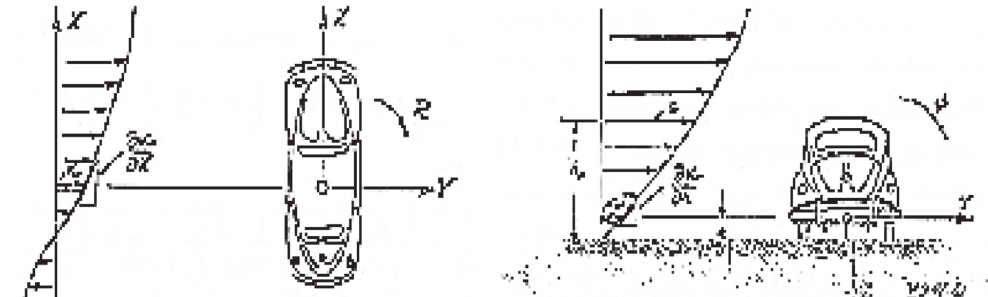
Figure 3: Characteristics of the opposite wind speed by Larabi and Hawk [6].